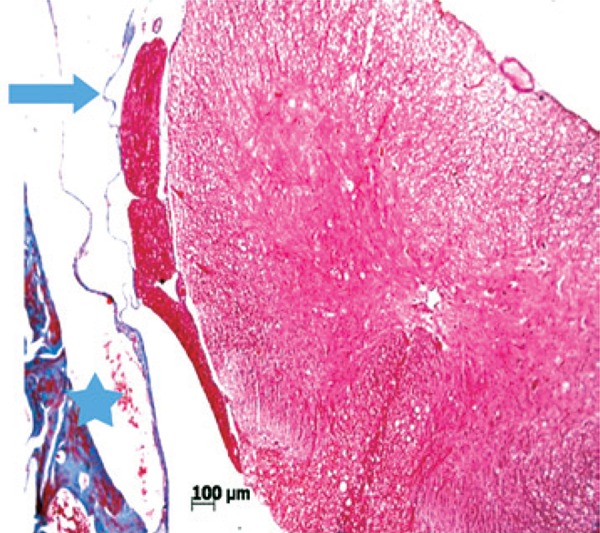
Fotomicrografia de um rato do Grupo DuraGen® (tricromo de Masson, 100X). Dura-máter com espessura normal na metade superior (seta) e espessada na metade inferior (estrela)